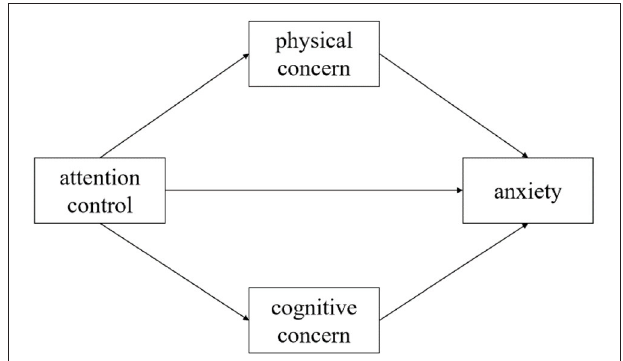
FIGURE 1 | Mediation model